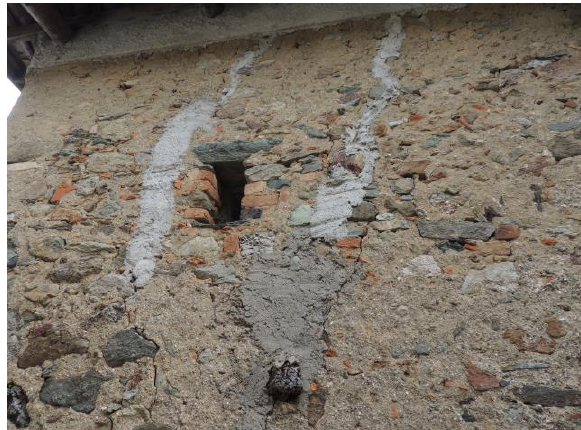
Figure 17. Building H - Preservation of the surface of the external wall and of the access portal (credits Silvia